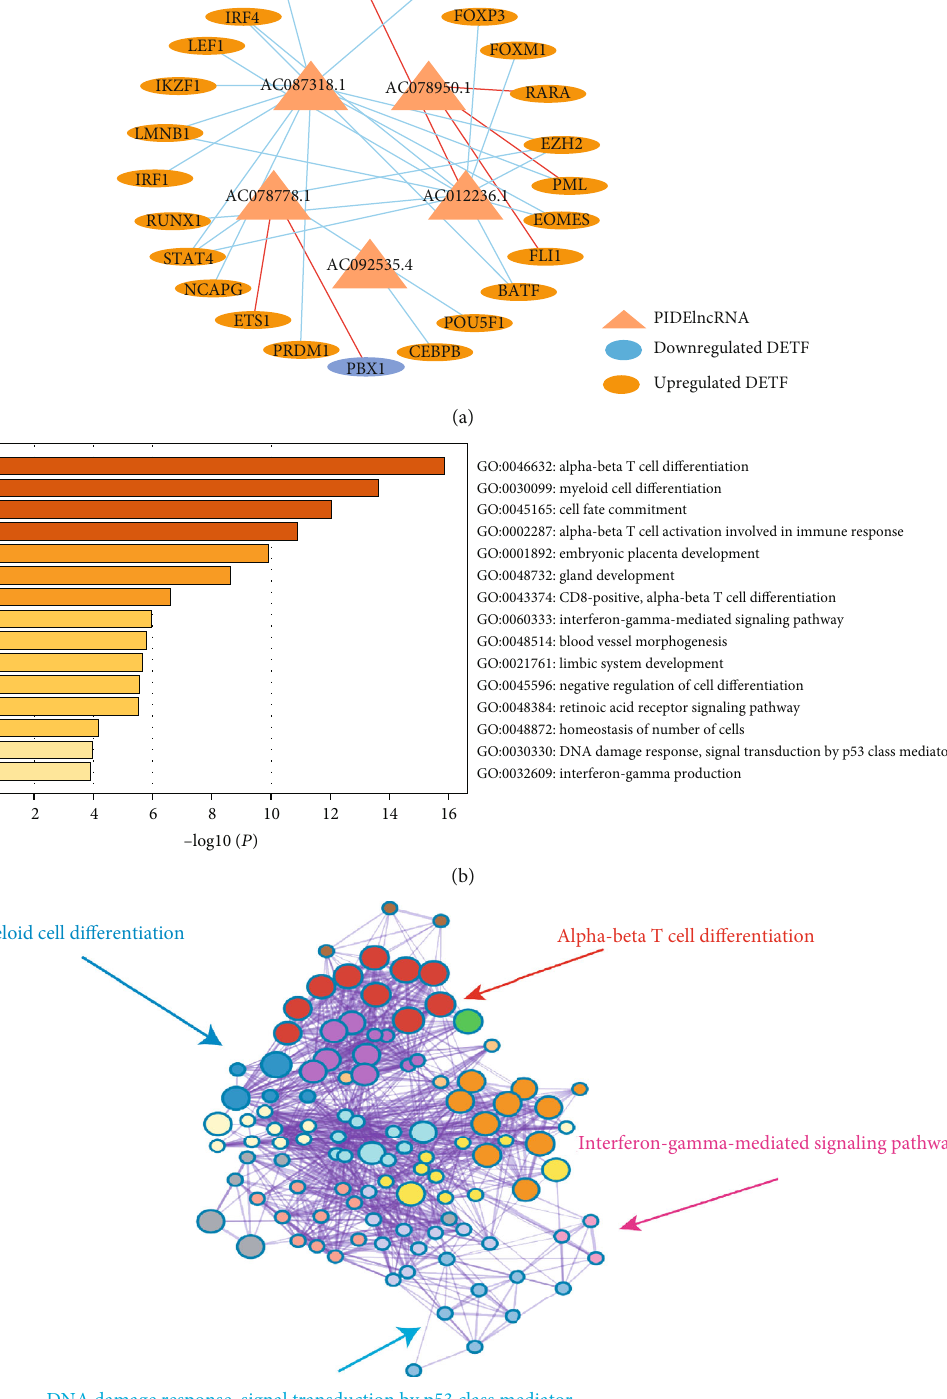
Figure 8: Regulatory relationship network of DETFs and fi ve PIDElncRNAs and GO enrichment analysis. (a) The network of DETFs and fi ve PIDElncRNAs based on TCGA and ICGC datasets. The orange triangles represent PIDElncRNAs; the orange nodes represent upregulated DETFs, while the blue nodes represent downregulated DETFs; the blue lines indicate positive regulatory relationships, while the red lines indicate negative regulatory relationships. (b) The relevant GO enrichment pathways of the coexpressed DETFs used in the lncRNA-TF regulatory relationship network. (c) The network of enriched GO terms for the coexpressed DETFs. DETFs: di ff erentially expressed transcription factor genes; PIDElncRNAs: prognostic immune-related di ff erentially expressed lncRNAs; GO: Gene